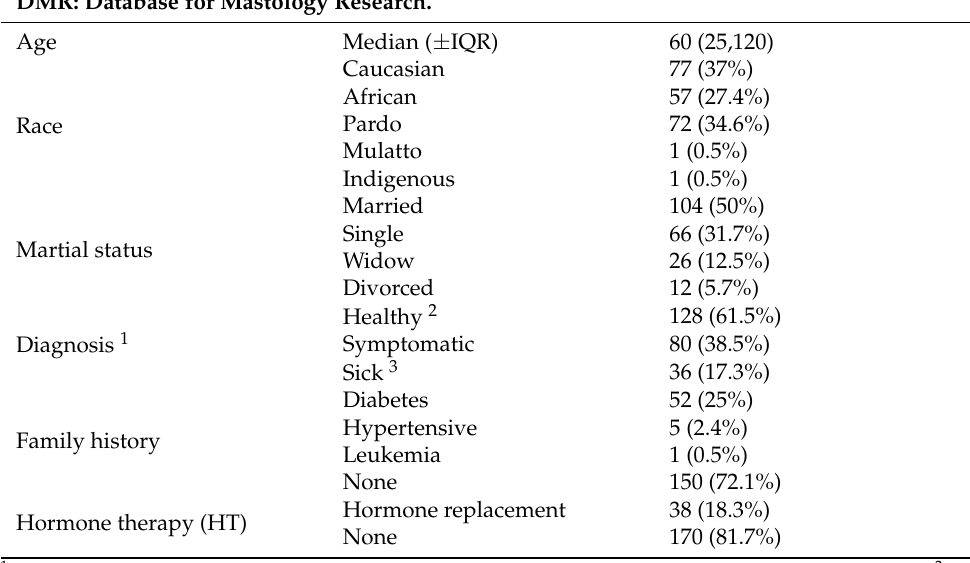
DMR: Database for Mastology Research.